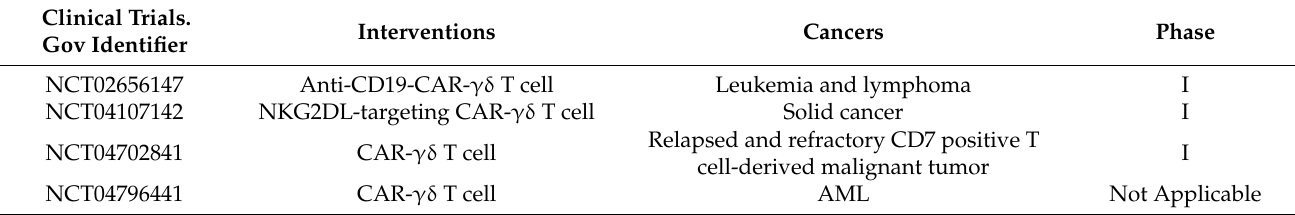
Table 2. CAR- γδ T cell-based clinical